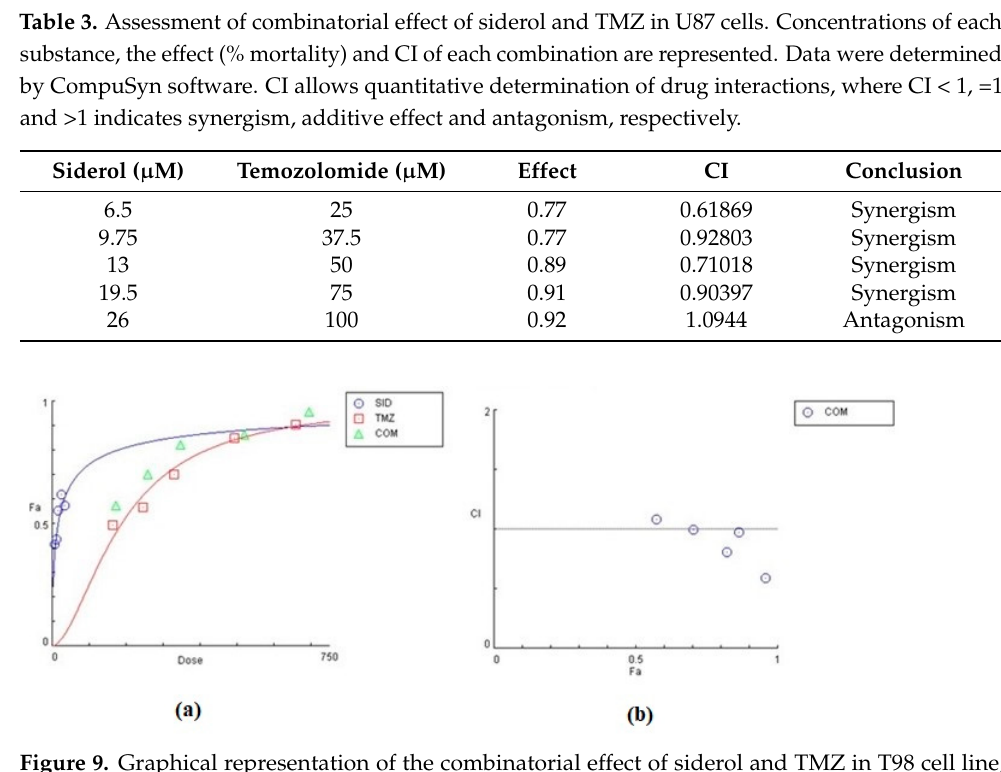
Figure 9. Graphical representation of the combinatorial effect of siderol and TMZ in T98 cell line, from CompuSyn Report. The dose-effect curve ( a ) for each substance, as for the combination of them. The x -axis represents the concentrations of substances and the y -axis the effect (% mortality). The Combination Index plot ( b ) represents the combinations where CI < 1, =1 or >1.